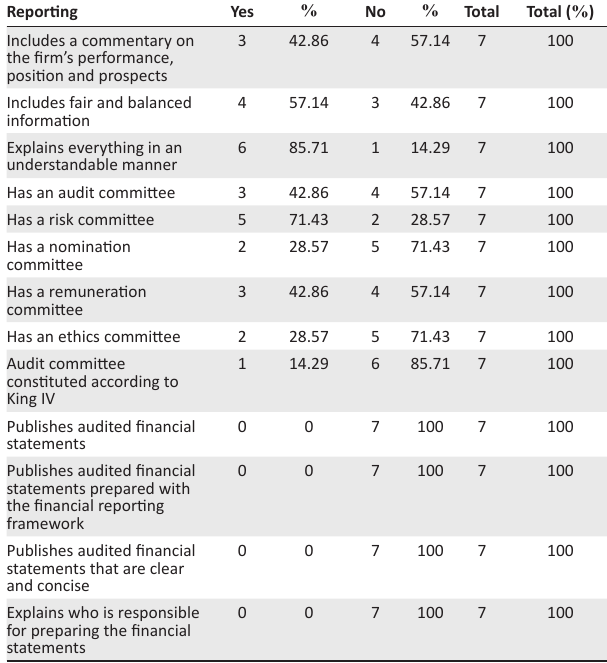
TABLE 6 : Findings on the reporting